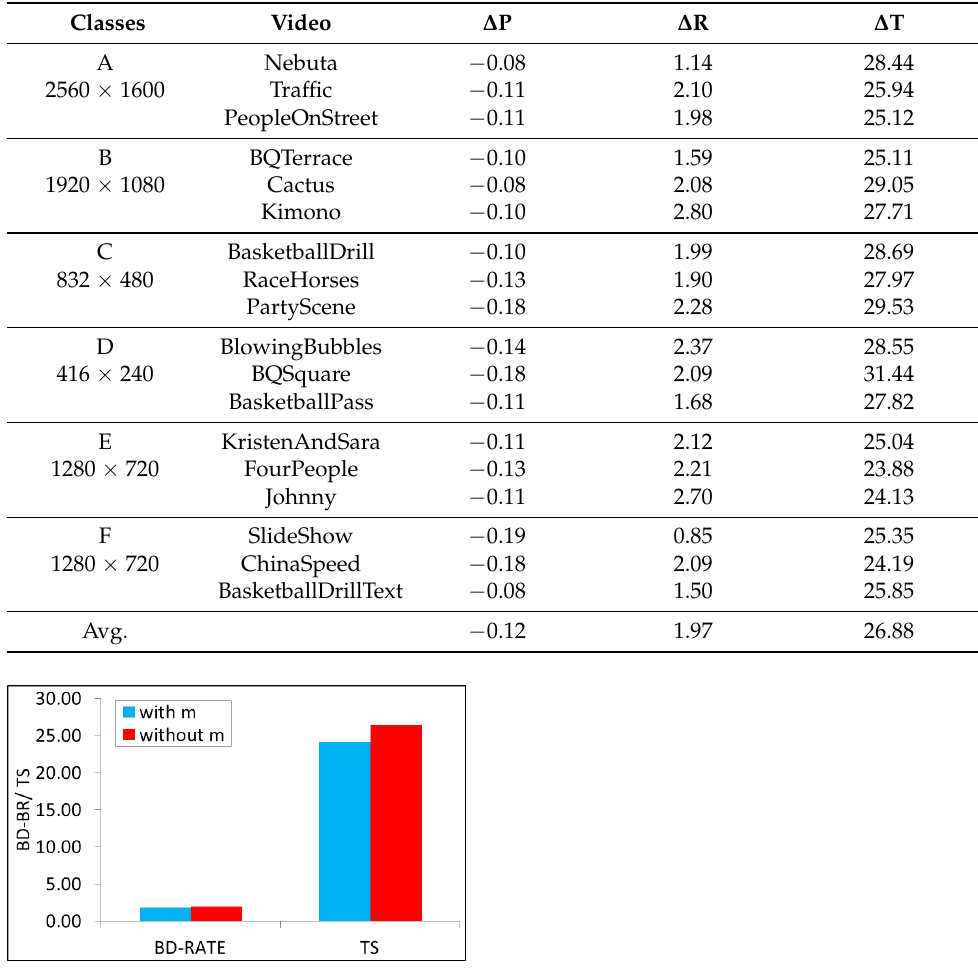
Figure 8. Encoding result of with and without term m .